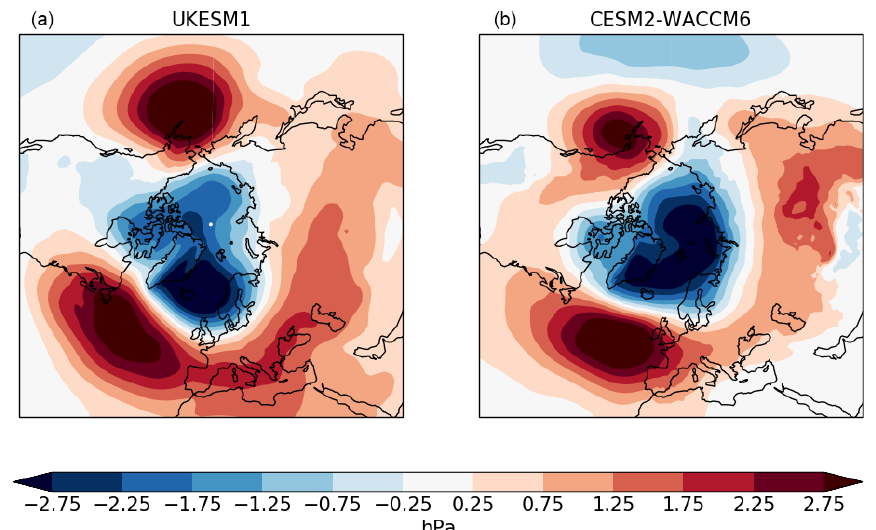
Figure 7. The change induced by SAI in 2081–2100 mean December–February MSLP (hPa) for UKESM1 (a) and CESM2-WACCM6 (b) diagnosed from { G6sulfur minus G6solar } .